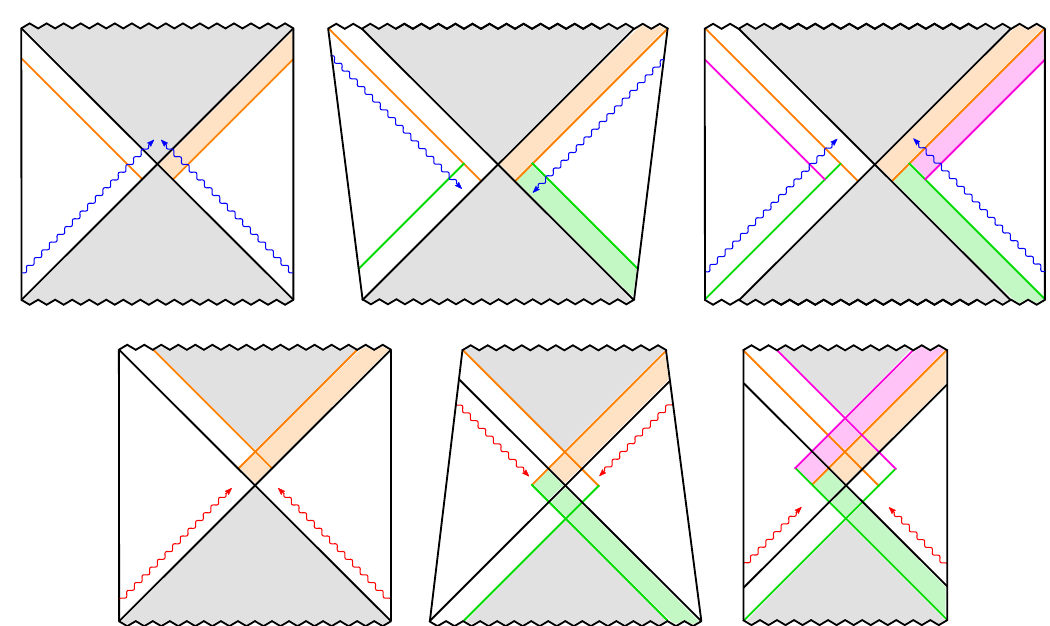
Figure 3: ( Top row ) TFD under sequential SS-type shocks, which move the horizons outwards. The original horizons are indicated in black, while their positions under the first three shocks are shown in orange (first shock, left), green (second shock, middle), and pink (third shock, right). The portion of the right exterior wedge N R lost behind the horizon after each inclusion is shaded according to this same scheme, while the original interior is shaded grey. ( Bottom row ) TFD under sequential GJW- type shocks, using the same color scheme above. In this case, the horizons move inwards, so the interior of the black hole shrinks. Note the increasing overlap be- tween the exterior wedges N i